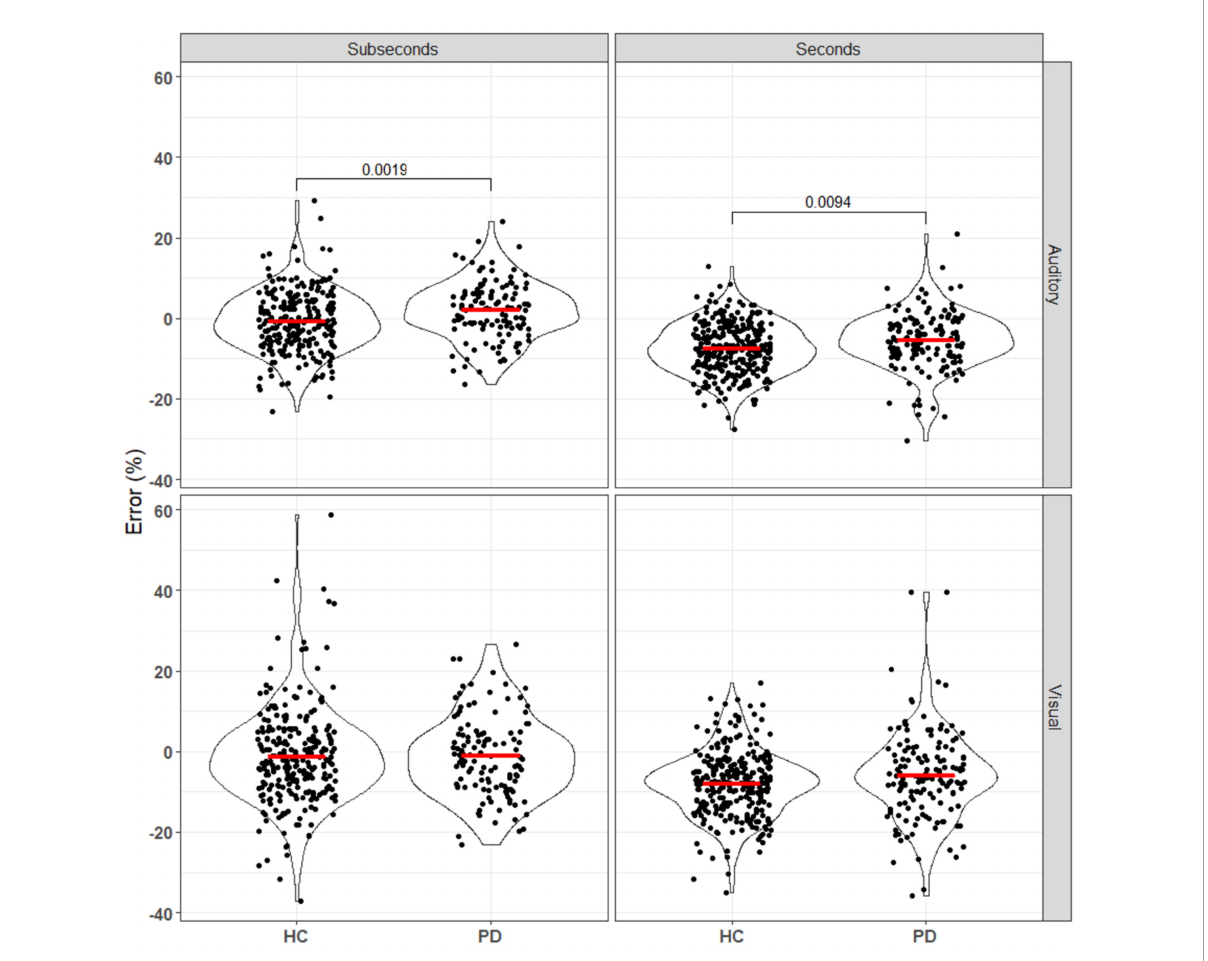
FIGURE4 Error of patients and controls in comparing auditory and visual stimuli in the seconds and subseconds intervals (Equation 3). No significant difference was seen between the patient and control groups for the visual stimuli. For the auditory stimuli, PD patients overestimated the standard duration compared to the controls. Annotations denote adjusted p -values after Bonferroni correction, only statistically significant p -values are